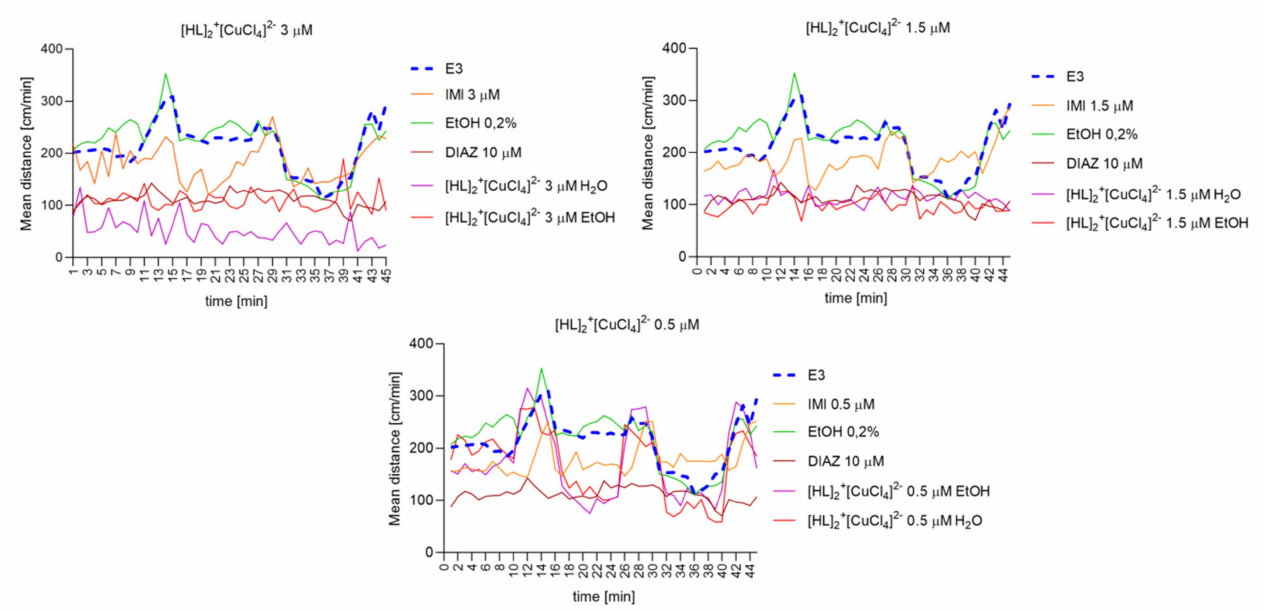
Figure 12. The changes detected during 45 min of the locomotor activity test (three 15-min light–dark sessions: 0–10-min of illumination followed by 11–15 min of darkness, 16–25 min of illumination followed by 26–30 min of darkness, and 31–40 min of illumination followed by 41–45 min of darkness) after 40 min of continuous illumination) under the influence of different concentrations of [HL] 2+ [CuCl 4 ] 2 − in the solvent-dependent and light–dark-dependent manner of